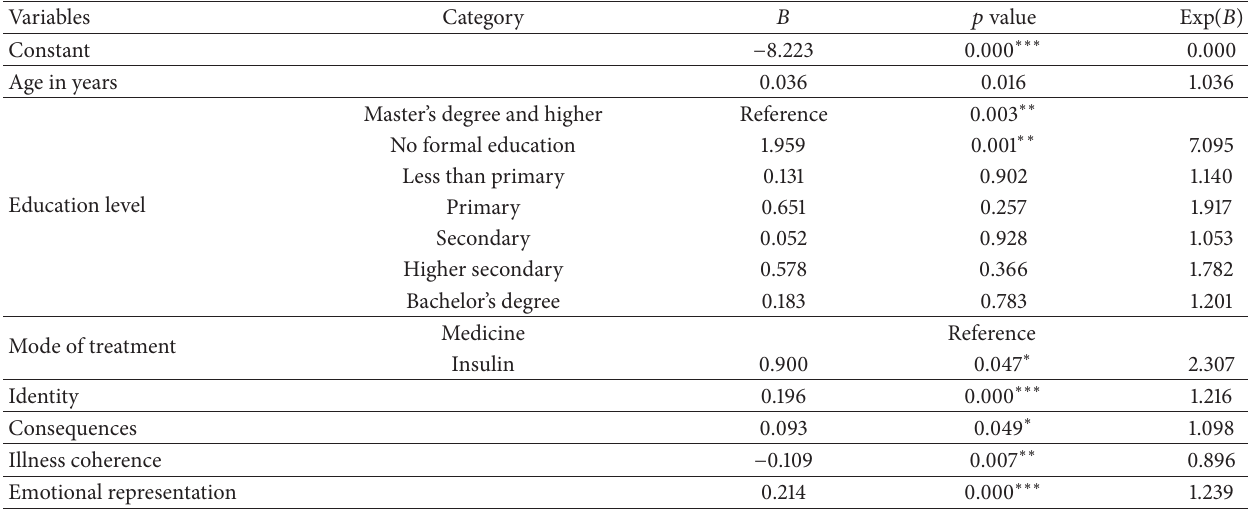
Table 5: Multivariable analysis of depressive symptoms (binomial logistic regression, stepwise method).